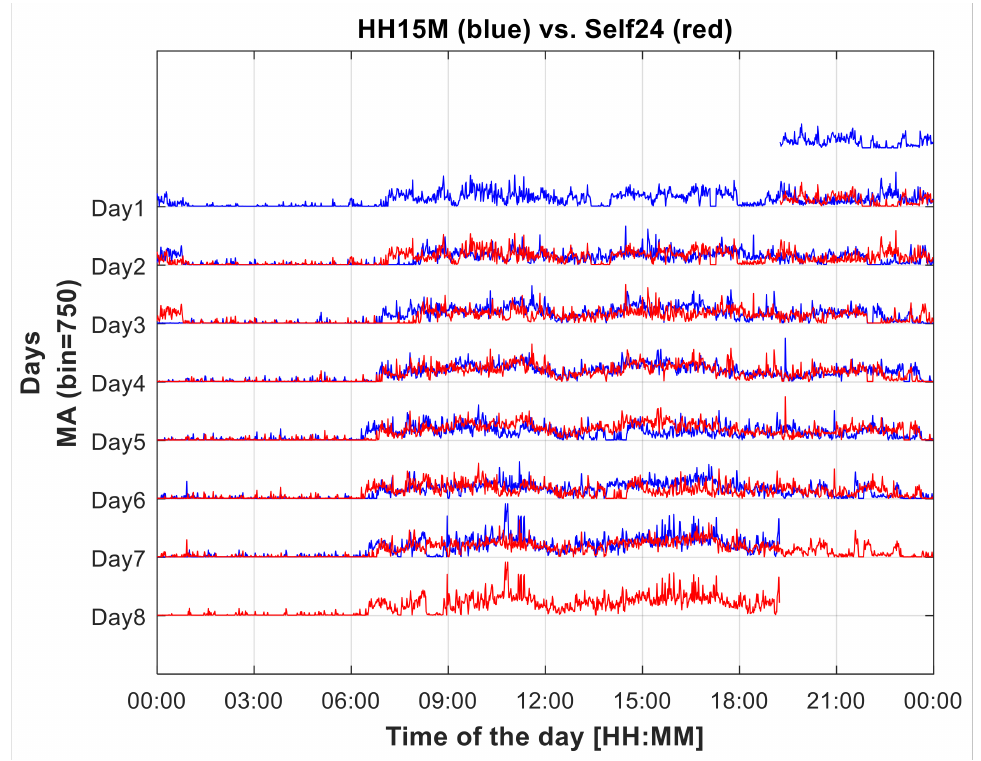
Figure 2. Plots of a week-long MA profile (HH15M, male, in blue) along with the 24-h shifted self (in red), i.e., the same MA profile shifted by 24 h, in order to show the best CC self24 (value: 0.50), the best association between an individual profile, and its 24 shifted one. The subject had a very regular daily timeline and habits, which led to a strong agreement between different days. CC self24 is computed on a 6-day overlap section of the